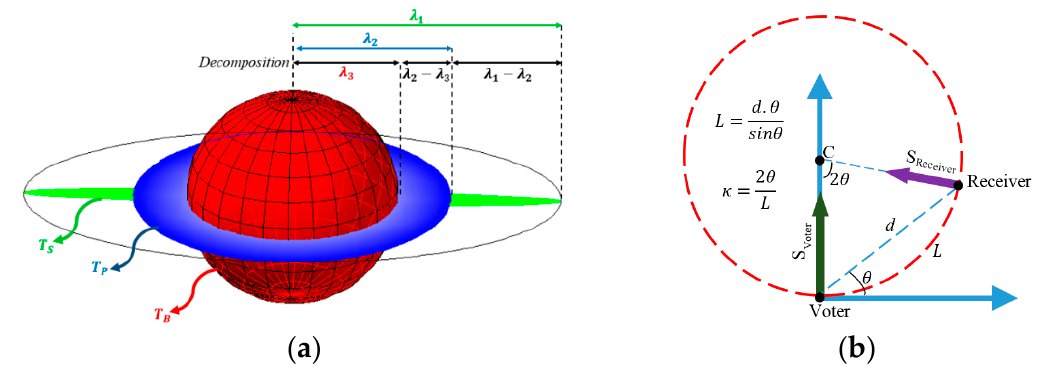
Figure 4. Tensor voting representation: ( a ) graphical representation of a second order tensor as its components (adapted from [55]); ( b ) stick voting from “Voter” token to “Receiver” token (adapted from [56]).